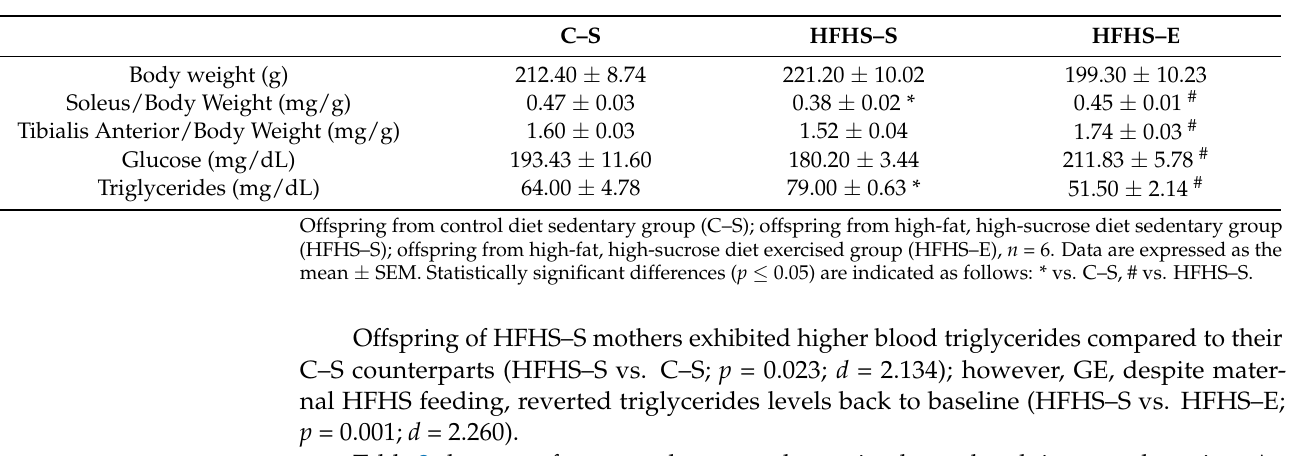
Table 1. Offspring body weight, SM weight, and plasma biochemical analysis.